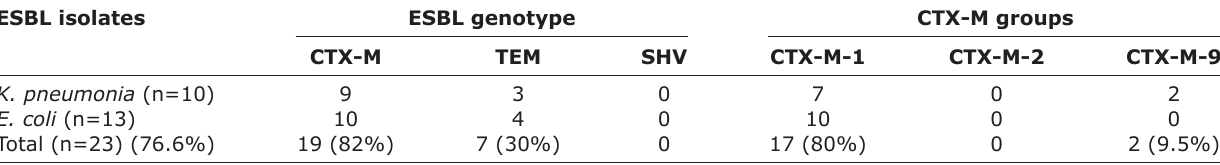
Table-3: Molecular characterization of bla genes among ESBL-producing K. pneumoniae and E. coli isolates. ESBL